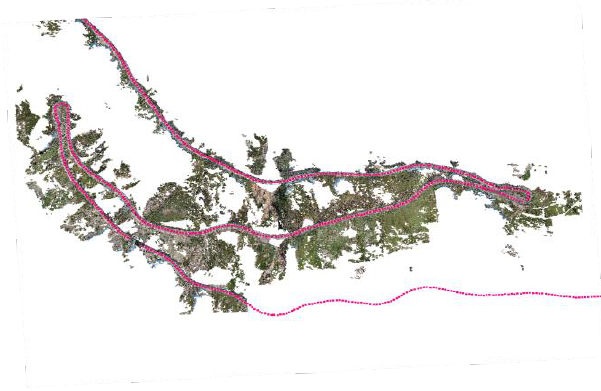
Figure 1. Point clouds (with colour) and trajectory (in red).